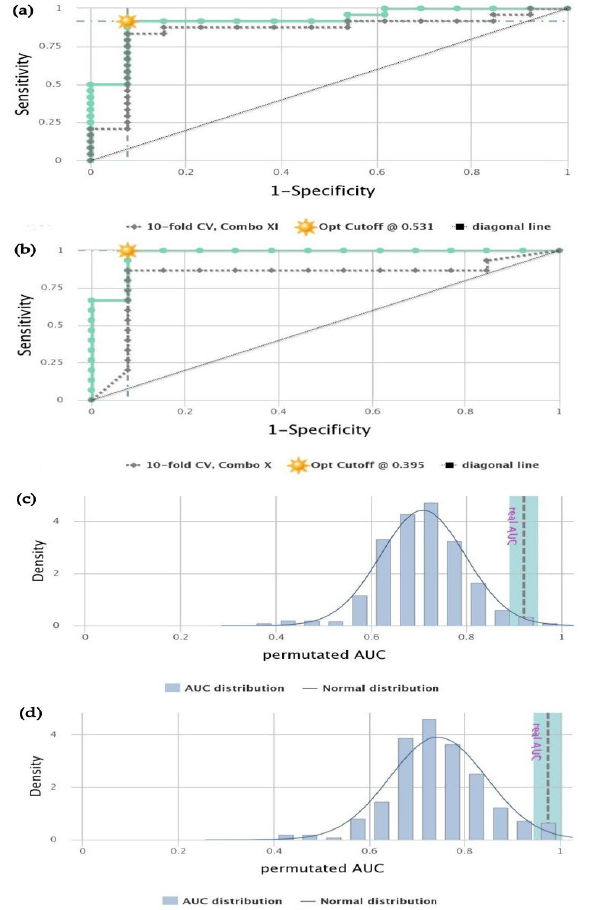
Figure 4. Performance of the quadruple-methylation marker panel. CombiROC curve analysis of the marker panel in discriminating ( a ) OC patients and ( b ) OPC patients from normal healthy controls. Green bar: receiver operating characteristic (ROC) curve of the marker panel for the whole cohort. Gray dotted bar: 10-fold cross-validation (CV) test of the marker panel. Diagonal line: reference line with zero discriminating power (0.5 sensitivity and specificity). Density distribution of permutated area under the curve (AUC) values compared to the normal distribution, illustrating the significance of real AUC value generated for discriminating ( c ) OC subjects and ( d ) OPC subjects from healthy controls.